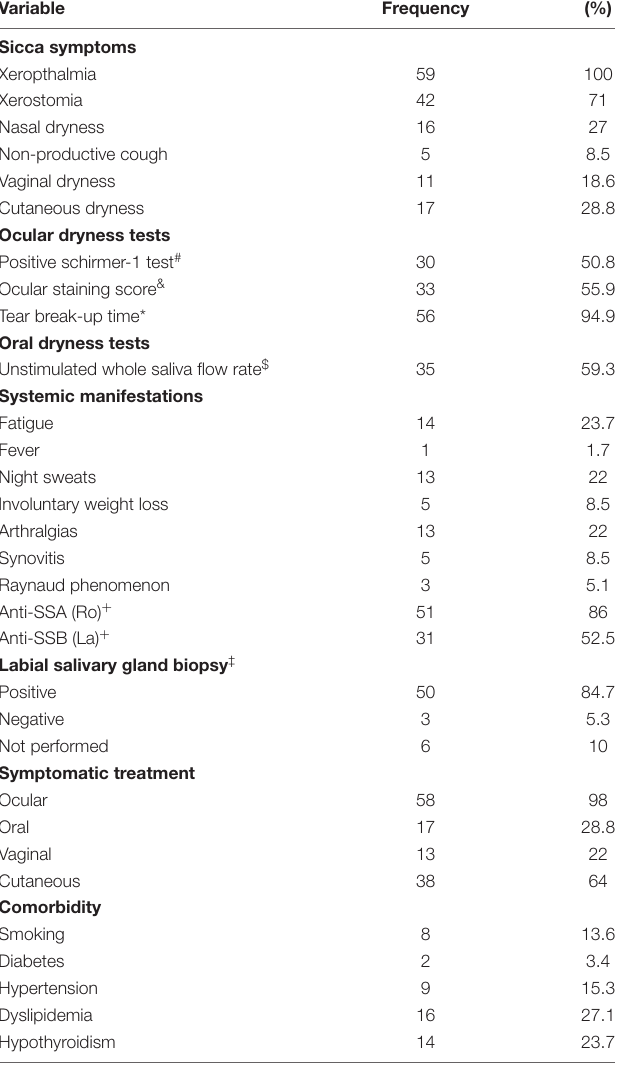
TABLE 1 | Characteristics and treatment of 59 women with primary Sjögren